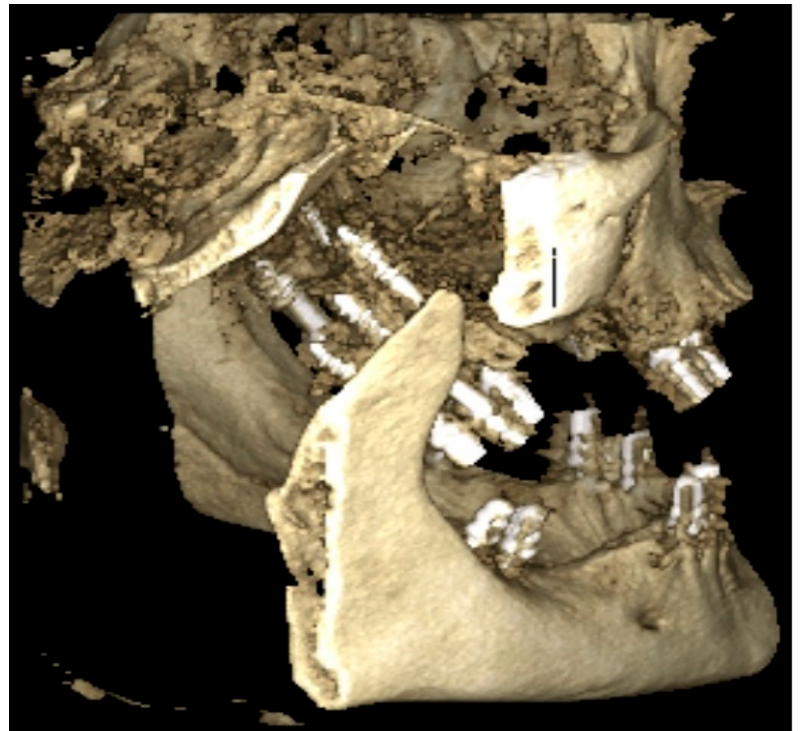
Figure 5. Visualization of the partial maxillary resection.